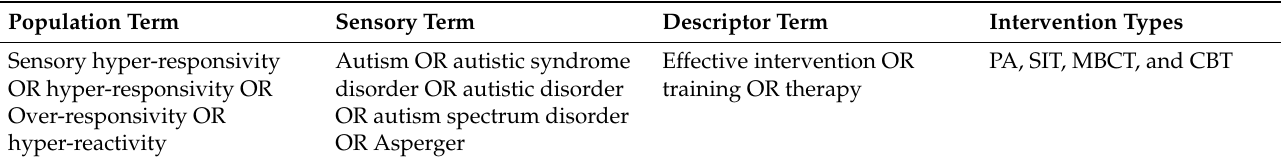
Table 1. Search terms in studies of